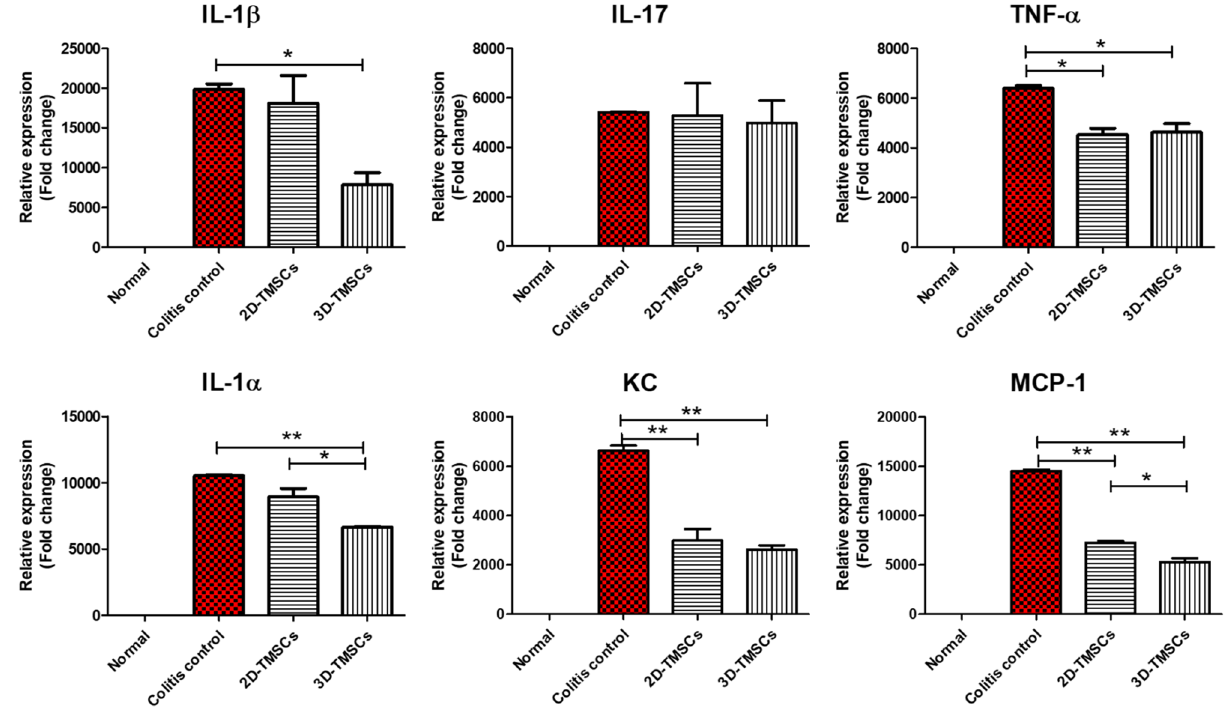
activation, such as KC and MCP-1 were significantly downregulated in the 3D-TMSC-treated group. *P < 0.05, **P < 0.005. 3D, three-dimensional; TMSCs, tonsil-derived mesenchymal stem cells; IL, interleukin; TNF-α, tumor necrosis factor α; KC, keratinocyte chemoattractant; MCP-1, monocyte chemoattractant